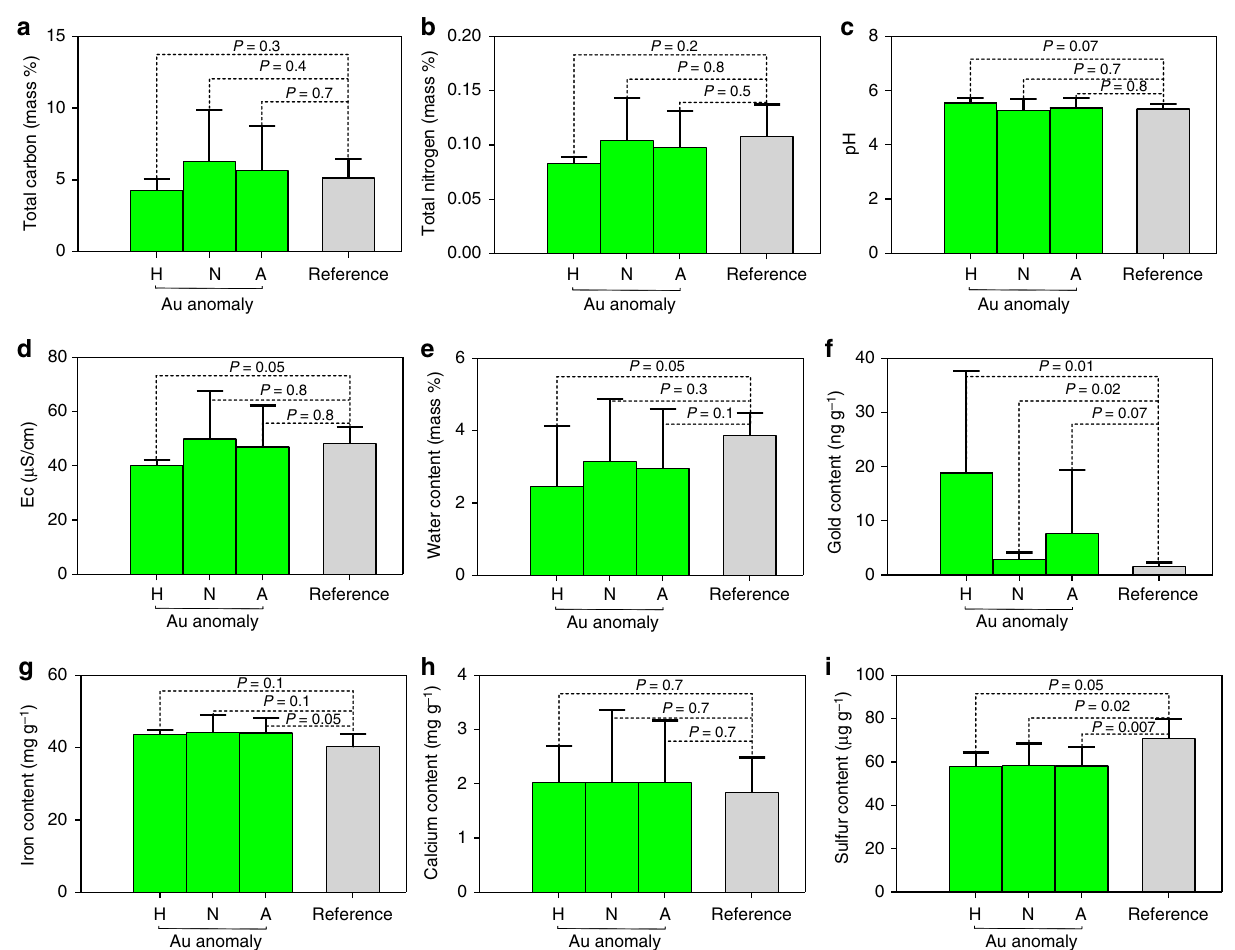
Fig. 1 Soil geochemical parameters of the gold anomaly and the adjacent reference area. a – i represent the values of total carbon, total nitrogen, soil pH, electrical conductivity, water content, the concentrations of gold, iron, calcium, and sulfur. The bars H, N, and A in each panel represent the data of the hotspots, the non-hotspots, and all spots of the gold anomaly, respectively. The signi fi cance of the differences between two sets of data was determined by an unpaired t -test (GraphPad Prism Version 7). The P value for gold content was based on a one-tailed t -test calculation. P < 0.05 was considered statistically signi fi cant. The error bar indicates the standard deviation